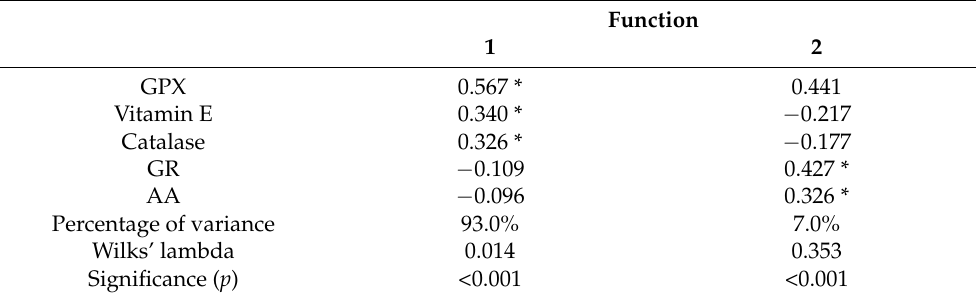
Table 3. Discriminant loadings of variables indicating antioxidants included in discriminant analysis 1 (DA1) with percentage of variance, Wilks’s lambda, and the significance of each discriminant function.